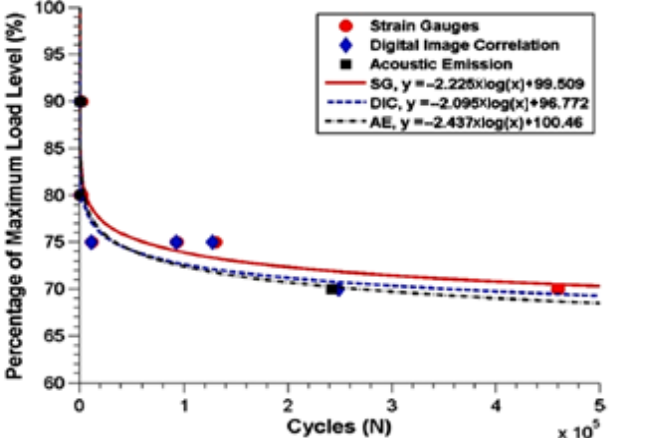
Figure 10. Fatigue lifetimes of all fatigue specimens based on different measurement methods